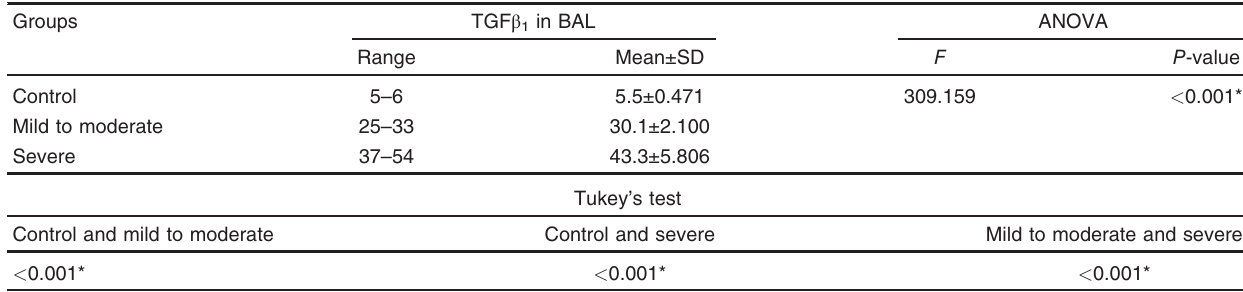
Table 5 Statistical comparison of range, mean±SD values of bronchoalveolar lavage fluid levels of transforming growth factor β 1 (ng/ml) in the three studied groups Groups